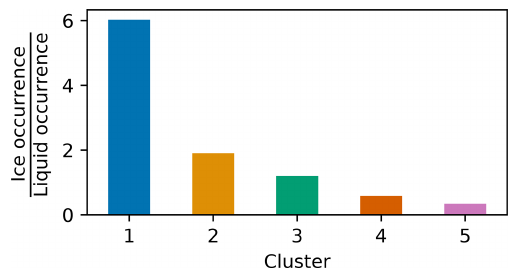
Figure 10. Ratio of ice to liquid occurrence per cluster based on Cloudnet retrieval. The bar chart shows, for each cloud residual size distribution cluster, the average ratio of pure ice to pure liquid oc- currence, i.e. Cloudnet category 4 divided by Cloudnet category 1, around the altitude of Zeppelin Observatory. See Fig. S11 for a more detailed view on the average Cloudnet retrieval target classifications for each